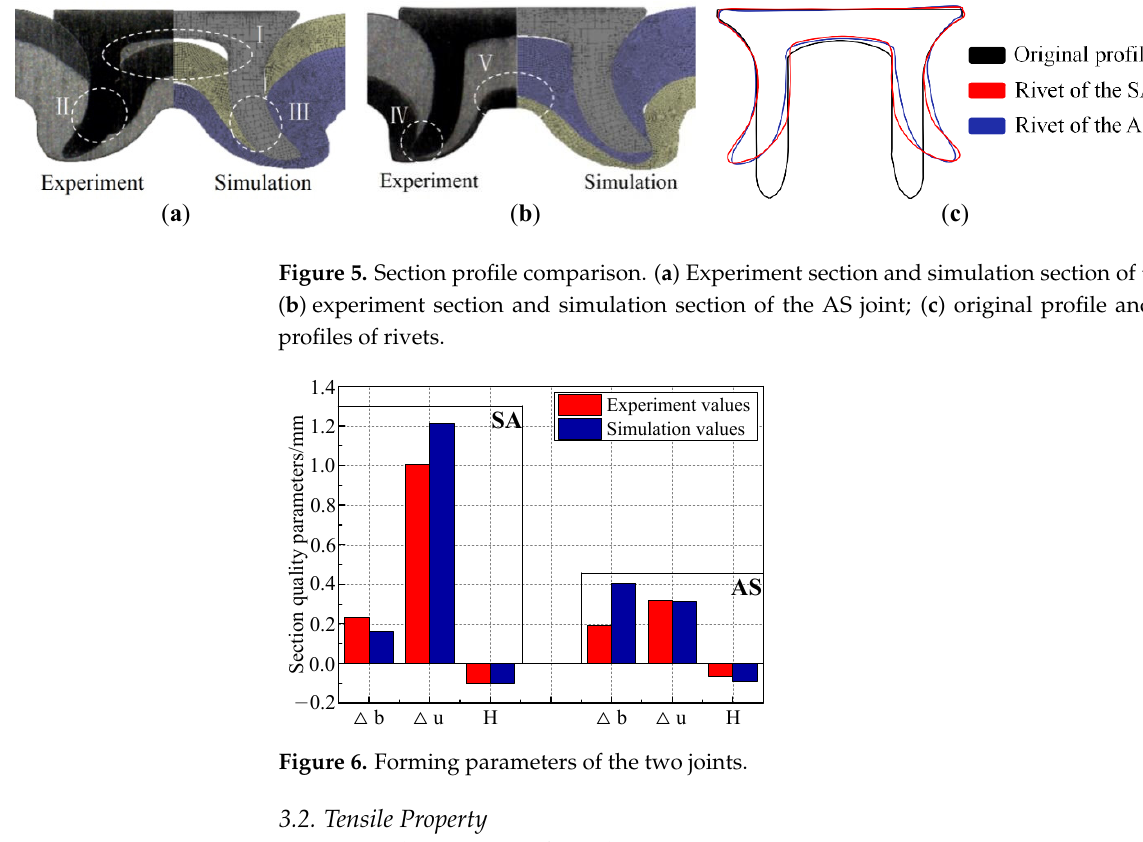
Figure 6. Forming parameters of the two joints.